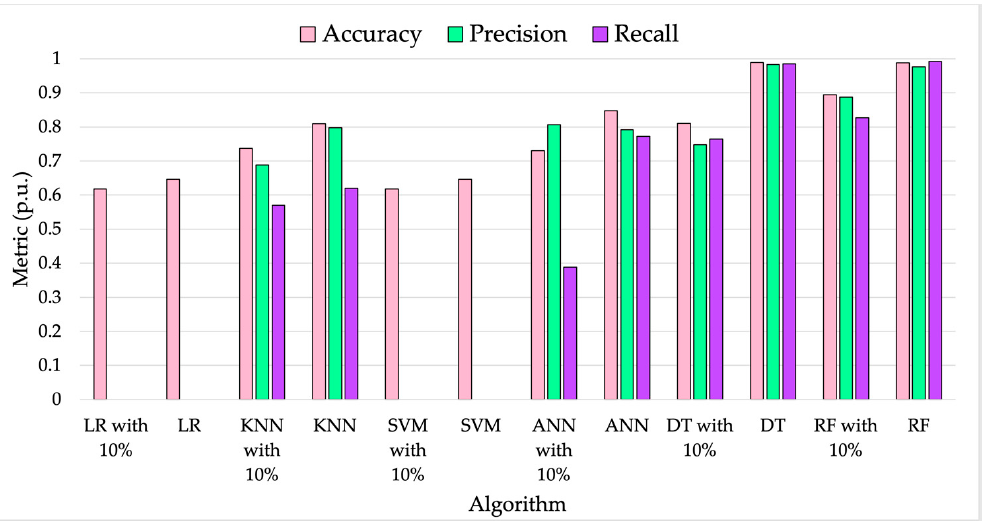
Figure 14. Algorithm metrics with and without the application of the 10% uncertainty contribution, with uniform distributed inputs.